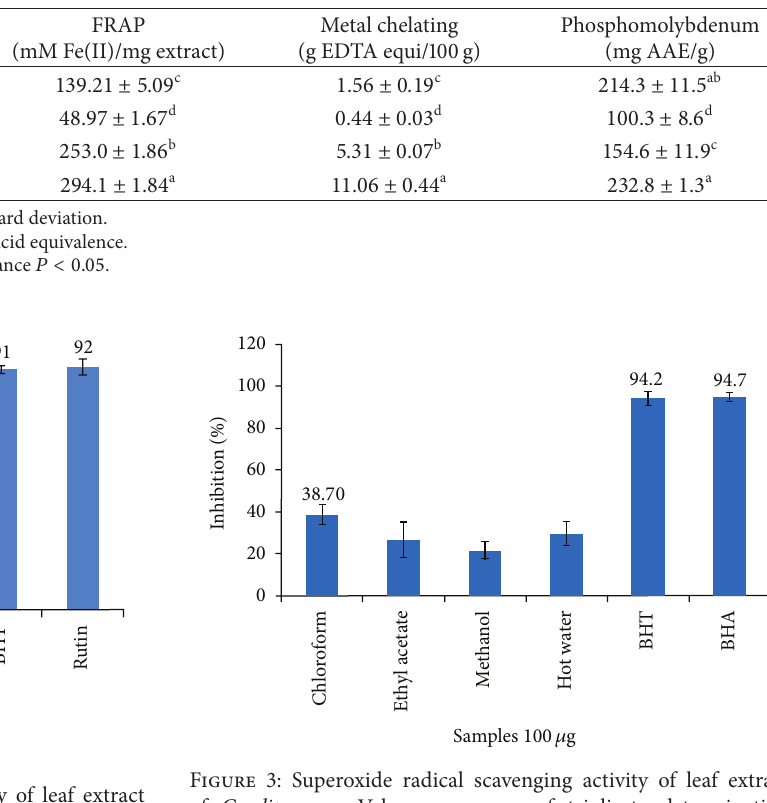
Figure 2: Nitric oxide radical scavenging activity of leaf extract of C. dipsaceus . Values are mean of triplicate determination (𝑛 = 3) ± standard deviation.